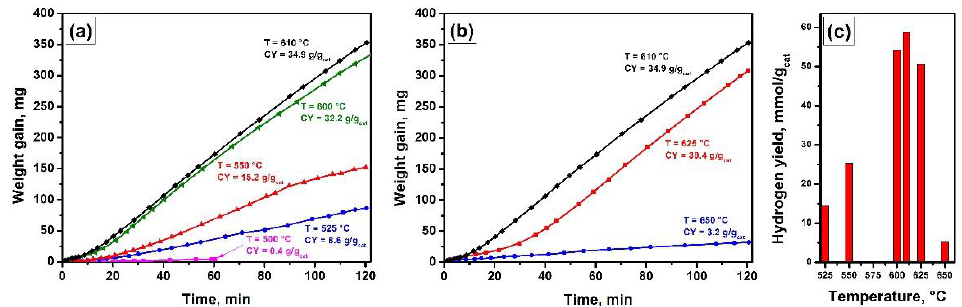
Figure 5. Carbon accumulation during the methane decomposition in the presence of hydrogen at varied temperatures ( m cat = 10 mg, G CH4 = 24 L/h, G H2 = 3.6 L/h): ( a ) in a range of 500–610 ◦ C; ( b ) in a range of 610–650 ◦ C. The corresponding values of carbon yield ( CY ) are shown below the temperature values. Hydrogen yield for the studied temperatures ( c